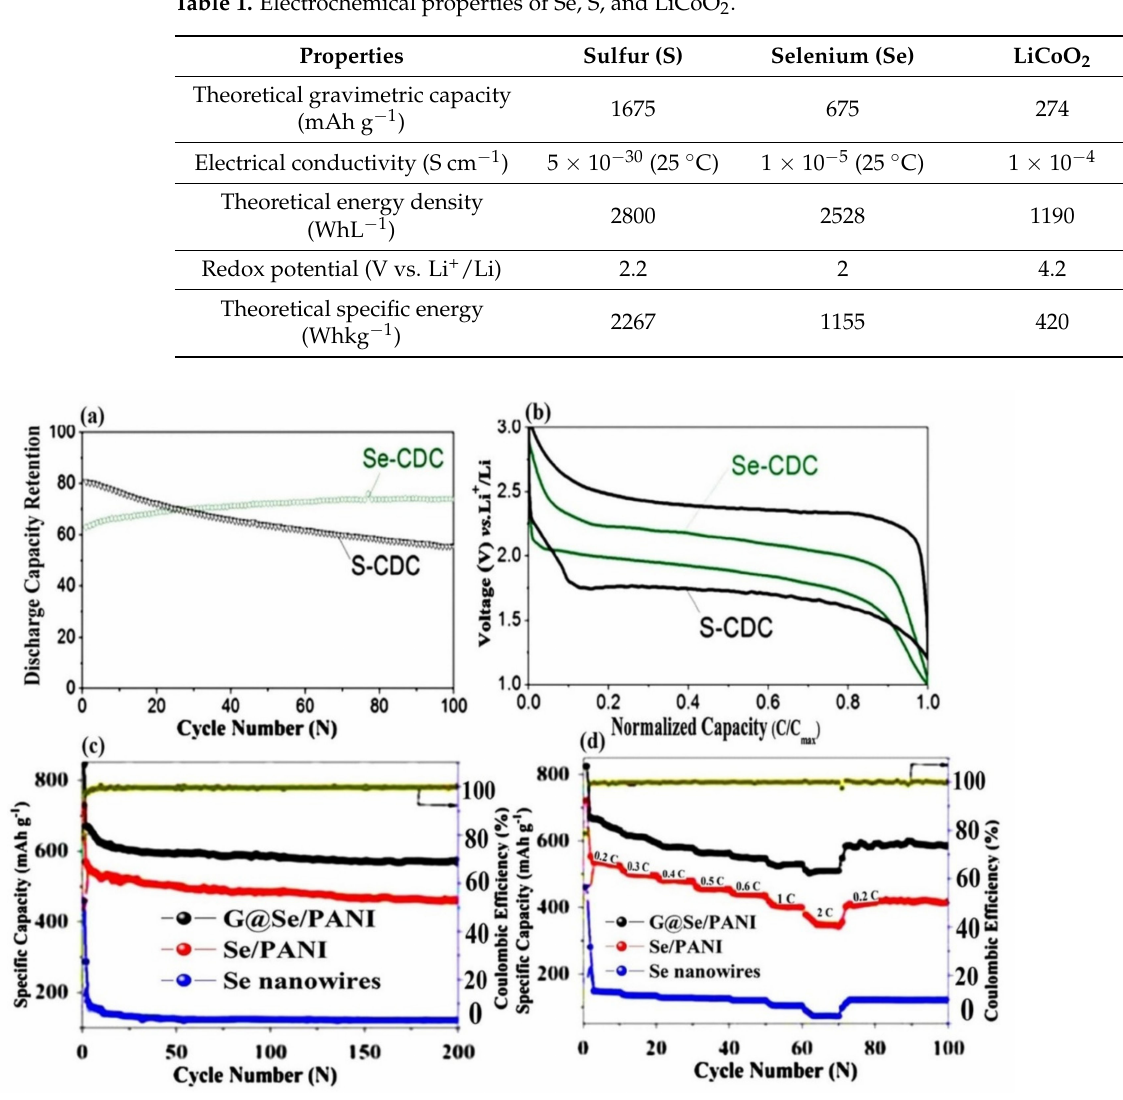
Figure 1. Comparison of the electrochemical performance ( a ) cyclic stability and ( b ) charge–discharge profile of Se-CDC and S-CDC in the same electrolyte (5 M LiTFSI). Reproduced with permission from [26], Copyright 2015, Wiley Online Library. ( c ) Cycle performance at a current density of 0.2 C between 1.0 and 3.0 V and ( d ) rate capability at various current densities between 1.0 and 3.0 V. Reproduced with permission from [27], Copyright 2015, Elsevier